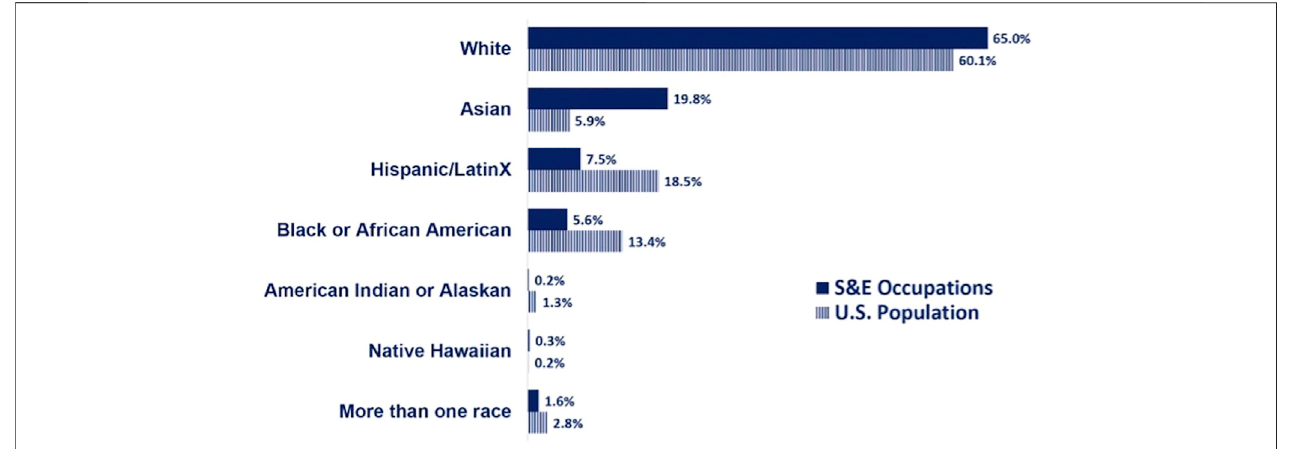
FIGURE 1 | Comparison of the Racial and Ethnic demographics of United States STEM Workforce and the U.S.